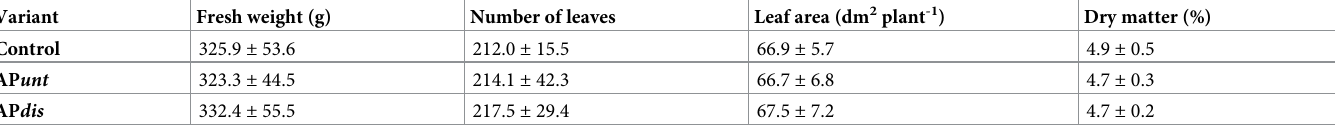
No significant differences (p < 0.05) were detected by post hoc Tukey HSD test (FW) or Dunnett-T3 test (DM) as well as Kruskal-Wallis test between the different